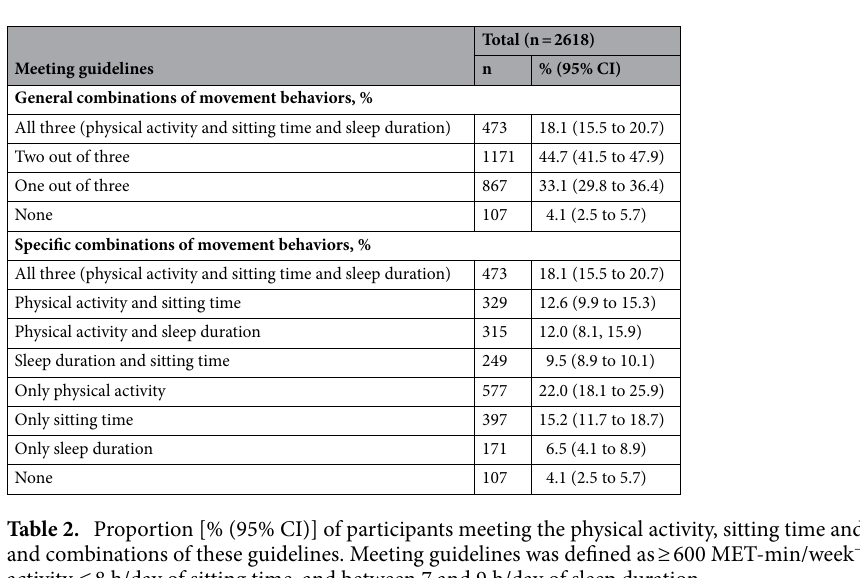
Table 1. Participants socidemographic characteristics, lifestyle risk factors, and cardiometabolic health indicators according to 24-h movement guidelines. CVD Cardiovascular disease.